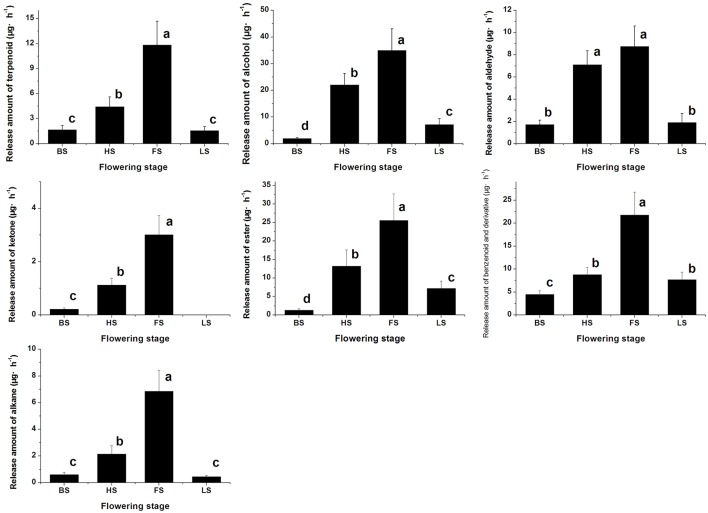
The amounts of different categories of components in the floral scent emitted by Lilium ‘Novano’. Each bar is the average of three independent biological replications, and standard errors are shown. Statistical significance [least significant difference (LSD)] of the difference in the amount of floral scent released is indicated by different small letters (P < 0.05).